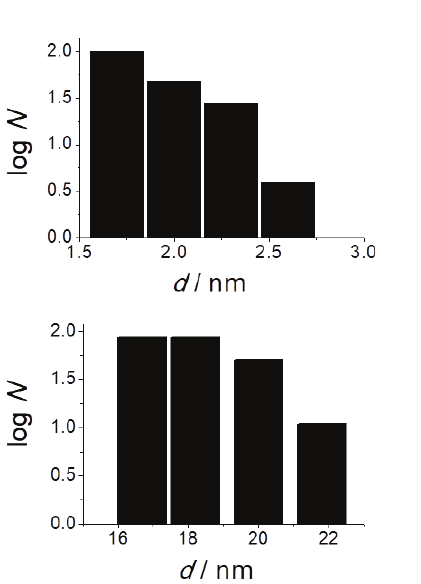
Fig. 1 – Particle size distribution of PAA-stabilized AgNPs (top) and PMA-stabilized AgNPs (bottom). Sample dilution was in all cases φ =